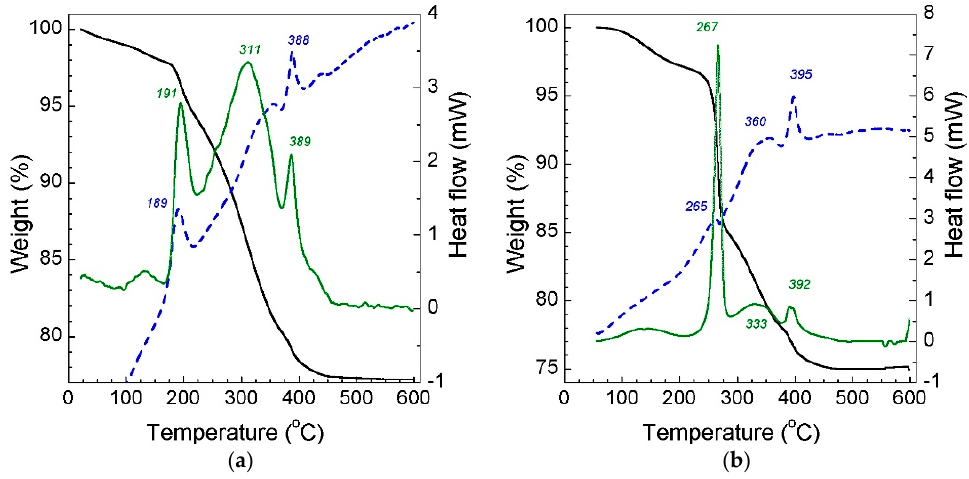
Figure 7. TGA (black solid curve), DTG (green solid curve) and DSC (blue dash curve) curves of the cured suspensions with 33 vol.% of 3YSZ: ( a ) IDA + TMPTA; ( b ) IBOA + TMPTA.